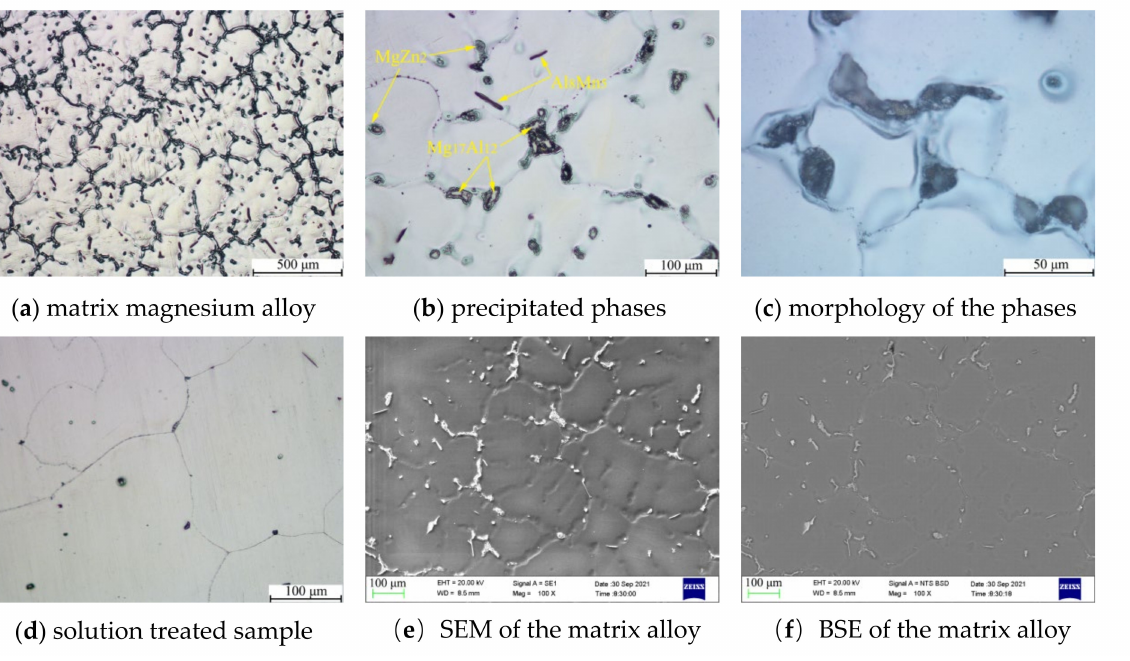
Figure 3. The microstructure morphology of Mg-Al-Zn-Mn-Si matrix